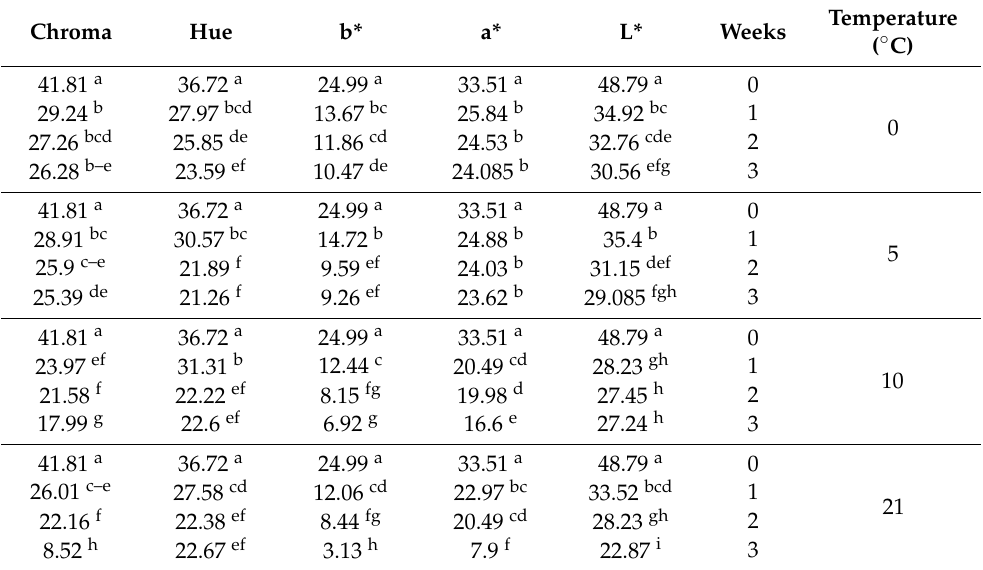
Table 2. Temperature effect on the color indices of cornelian cherry fruits treated with 1% chitosan during the storage